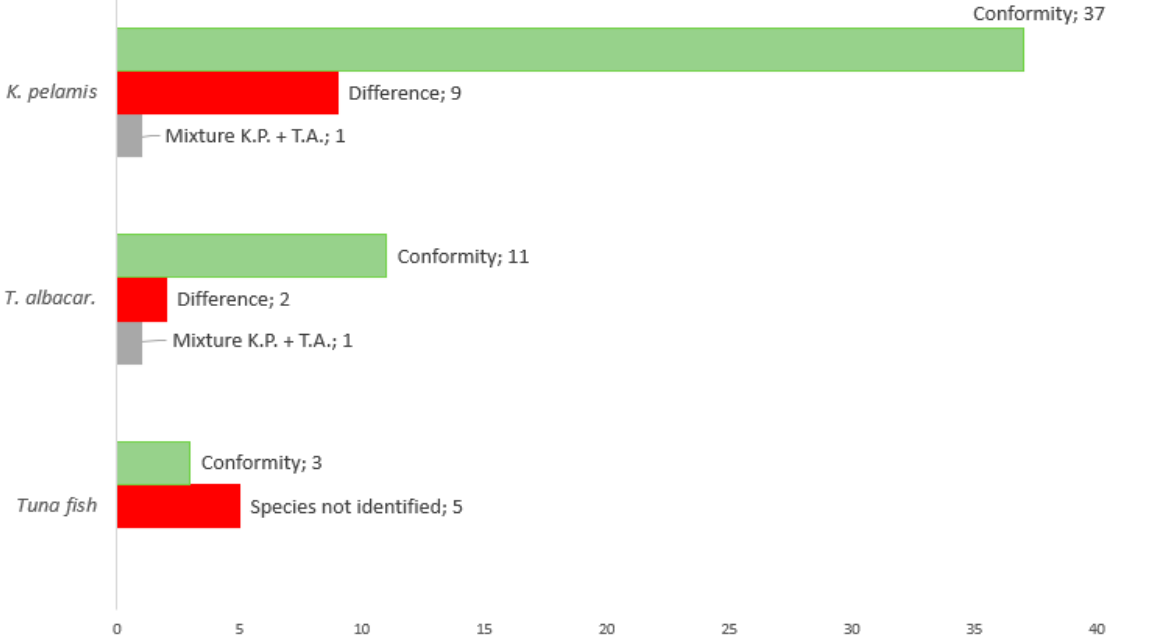
Figure 5. Evaluation of the declaration.